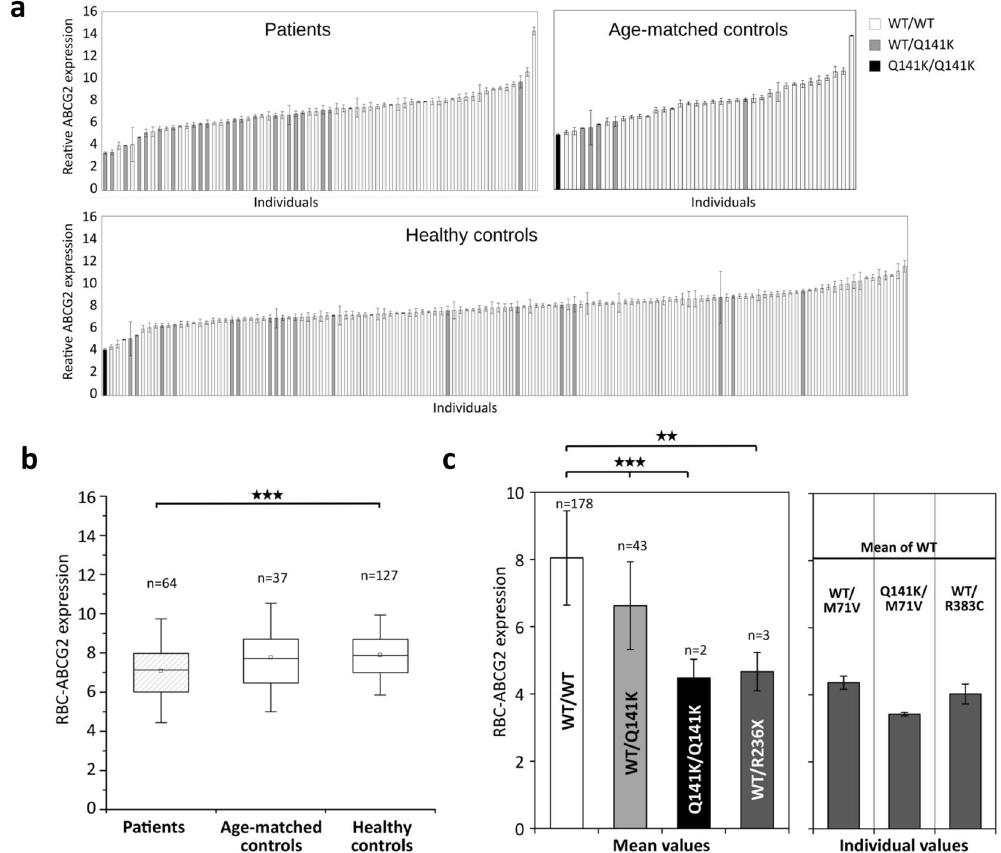
Figure 1. ABCG2 protein expression in the erythrocytes of gout + hyperuricemic patients and of control individuals - indication of the identified SNPs and mutations. (Panel a) Expression levels of ABCG2 in erythrocytes and the corresponding Q141K genotypes in gout patients and in control individuals. ABCG2 was detected by BXP-34 antibody and assessed by flow cytometry. The values represent the antibody labeling relative to isotype control. (Panel b) Mean values ± 25–75% quartiles (box) and ± SD (whisker) of erythrocyte ABCG2 expression levels in gout patients and in control groups ( *** p < 0.001). (Panel c) Left side: Mean values ± SD of erythrocyte ABCG2 expression levels in individuals carrying various polymorphisms and mutations. Right side: erythrocyte ABCG2 levels measured in individuals with identified specific mutations (mean values ±